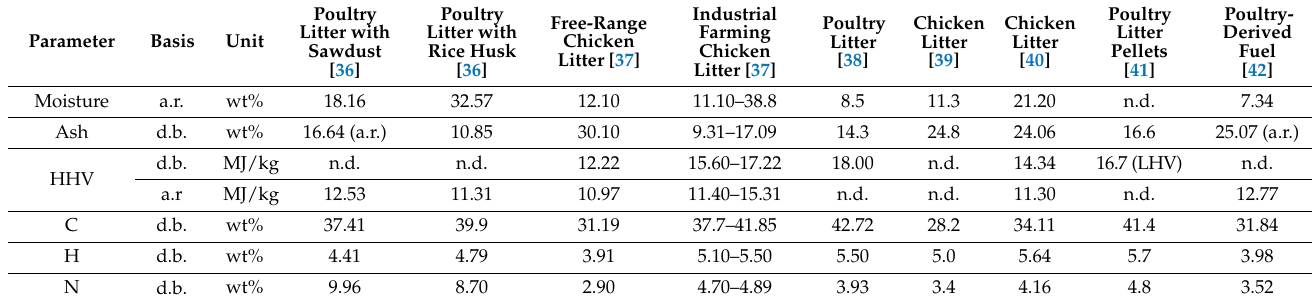
Table 1. Proximate and elemental (ultimate) analyses of poultry litter (a.r.—as received, d.b.—dry basis, and n.d.—no